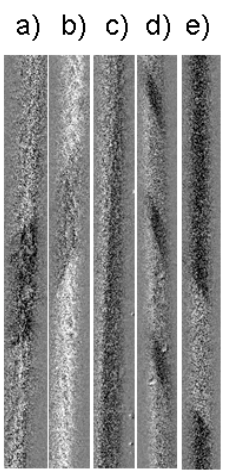
Figure 2. MOKE images of surface magnetic domains. Torsion strain: ( a ) − 8 π radm − 1 , ( b ) − 2 π radm − 1